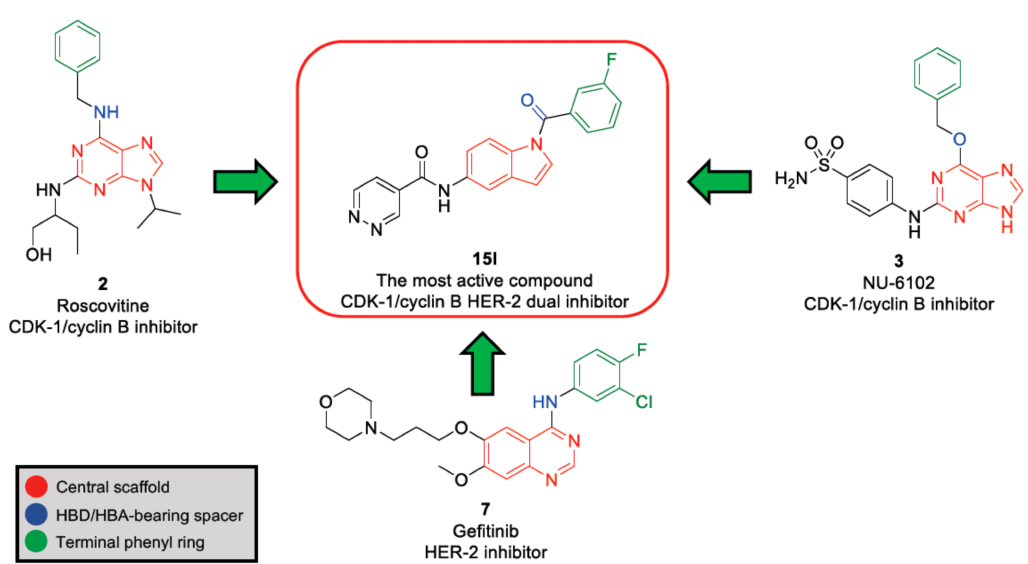
Figure 3. Structural correlation between the most active compound ( 15l ) and CDK-1/cyclin B inhibitors ( 2 , roscovitine and 3 , NU-6102) and HER-2 inhibitor ( 7 , gefitinib).